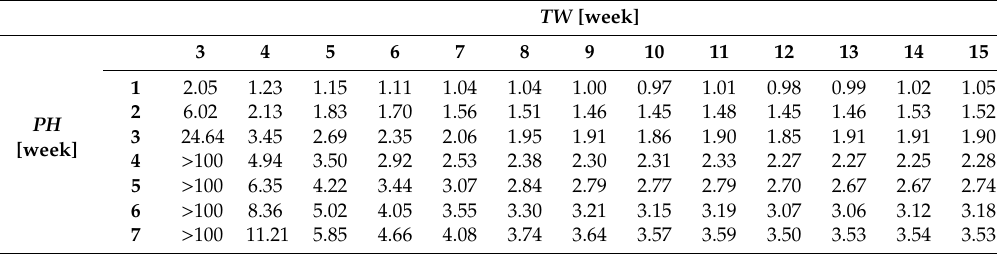
Table 5. Mean relative prediction error ( MRPE ), in percentage, for di ff erent combinations of time window ( TW ) and prediction horizon ( PH ) sizes, measured in weeks, when applying the dynamic auto-regression with exogenous variables (DARX) model. The values > 100 indicate an extremely low forecasting performance of the model.